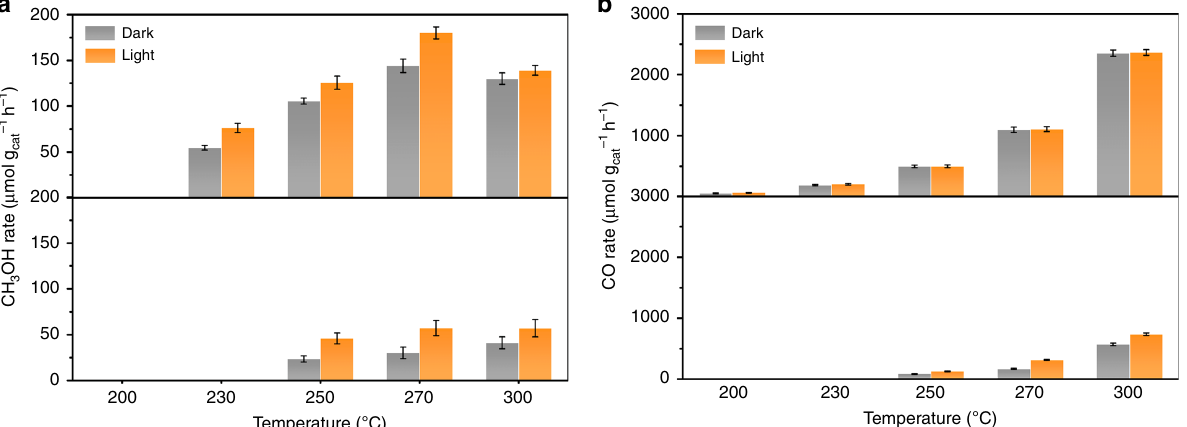
Fig. 2 Catalytic performance of rh-In 2 O 3-x (OH) y (up) and c-In 2 O 3-x (OH) y (down). a CH 3 OH production rate at different reaction temperatures with and without solar irradiation. b CO production rate at different reaction temperatures with and without solar the reference c-In 2 O 3-x (OH) y nanocrystals at similar reaction conditions. If catalytic performance is normalized on the basis of the speci fi c surface area, the rh-In 2 O 3-x (OH) y would show a solar CH 3 OH rate of 3.2 μ mol h − 1 m − 2 , which is ~ 5.8 times higher